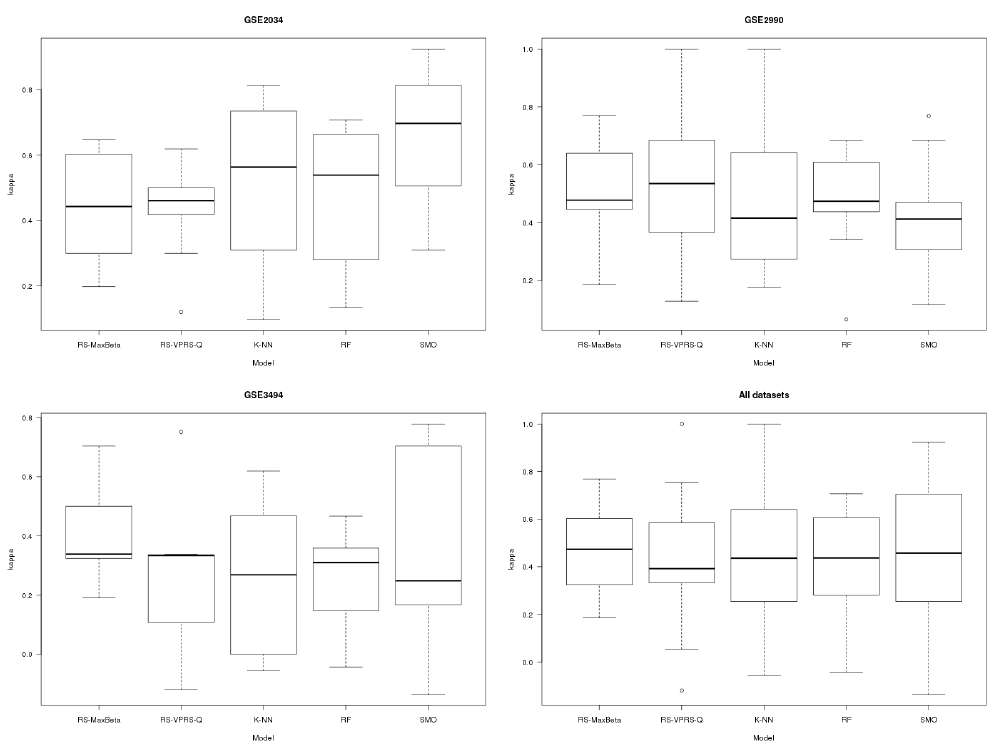
Figure 3: Comparison of the models kappa coefficient in each dataset and in all